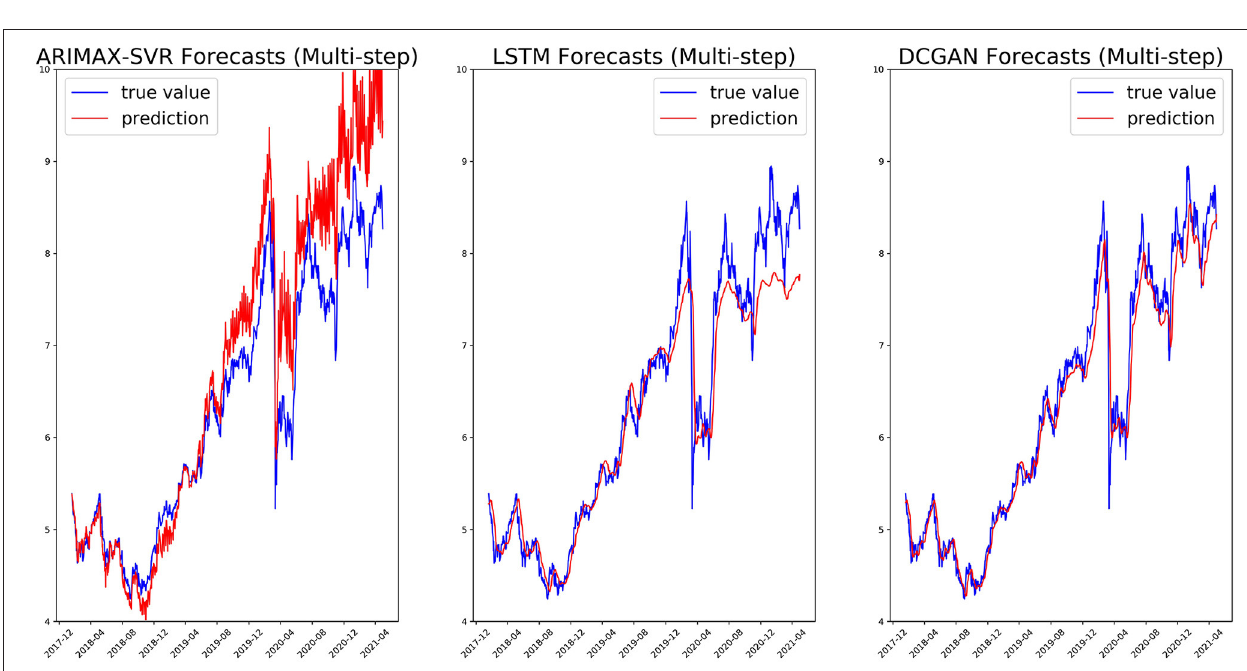
function for the hidden layers, dropout as regularization method, and Binary Cross Entropy (BCE)